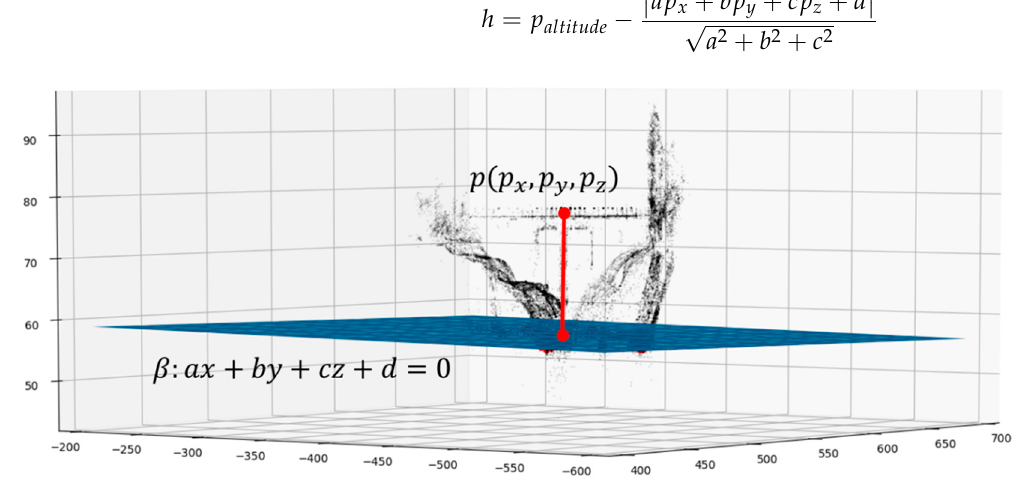
Figure 6. Distance between the plane of the water surface and the point of known altitude.